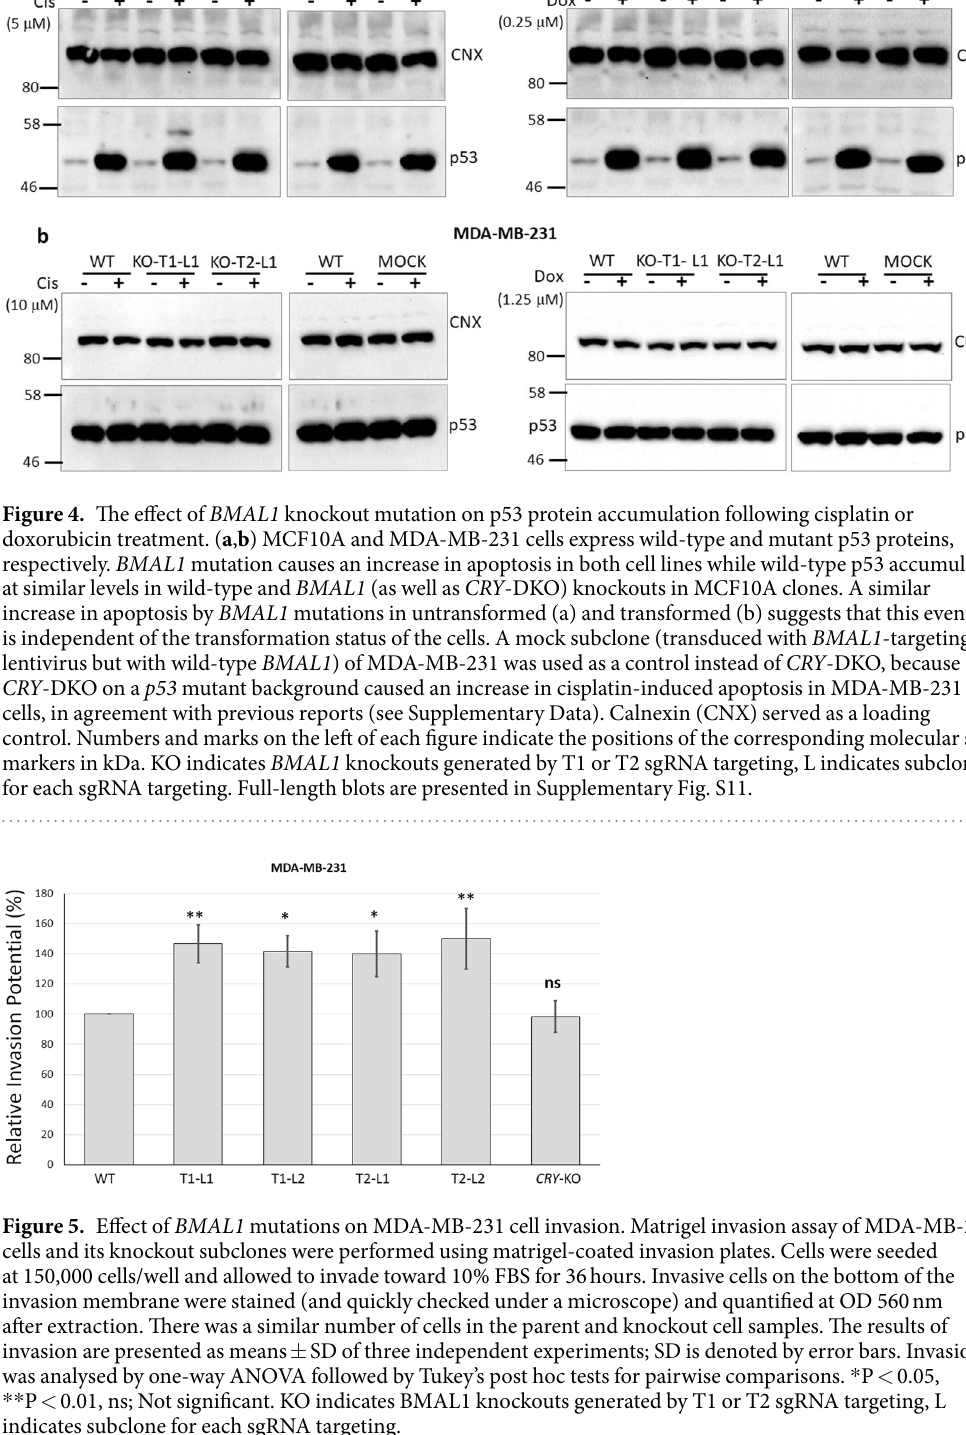
whole-body knockout of Bmal1 in mouse was recently associated with increased accelerated lung cancer 24 . In a similar organ specific targeting approach, Kettner et al . reported that hepatocyte-specific loss of Bmal1 enhances the formation of spontaneous hepatocellular carcinoma 40 . On the other hand, a study by Puram et al . suggested that genetic deletion of Bmal1 in established leukemias results in a competitive disadvantage and suppressed leukemogenesis 41 . In respect to the effect of Cry on carcinogenesis, it was reported that Cry DKO mice were not distinguishable from wild-type ones 15 , while Cry2 deletion increased the cancer risk 21 . In opposite to Cry DKO, the deletion of Cry genes in p53 null background had a protective effect against the spontaneous development of